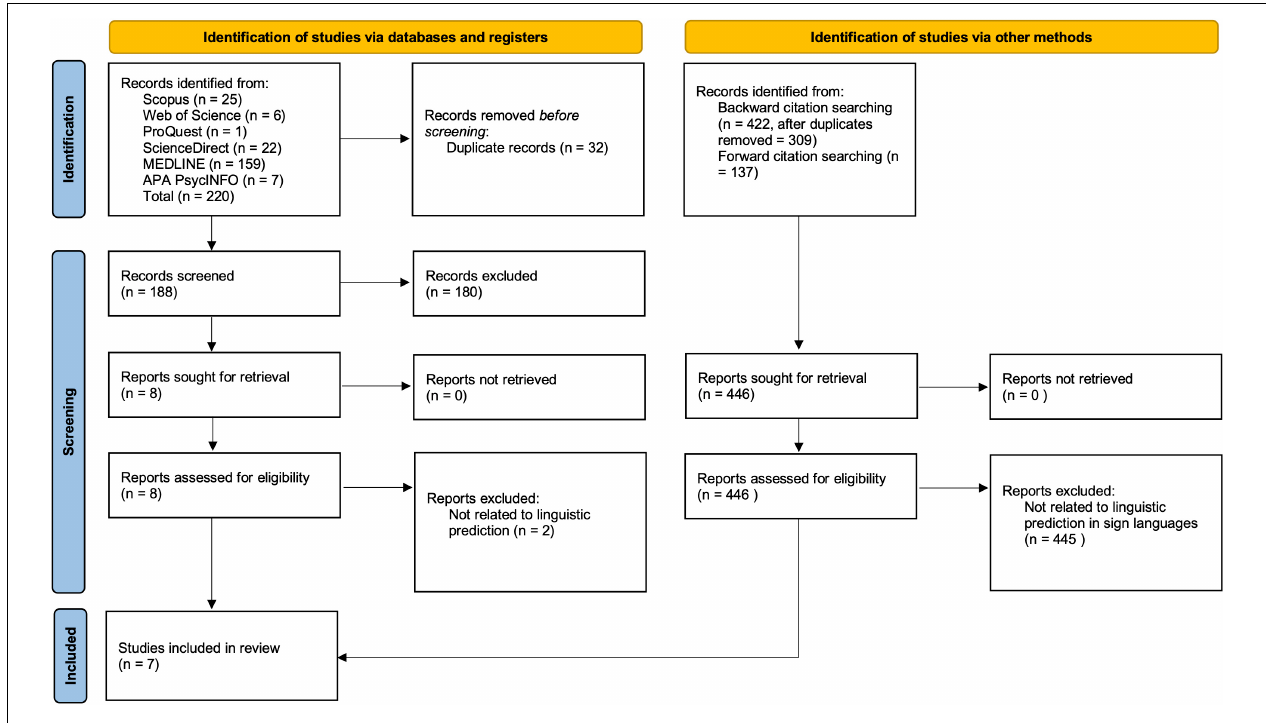
FIGURE 1 | PRISMA 2020 flow diagram (adapted from Page et al.,